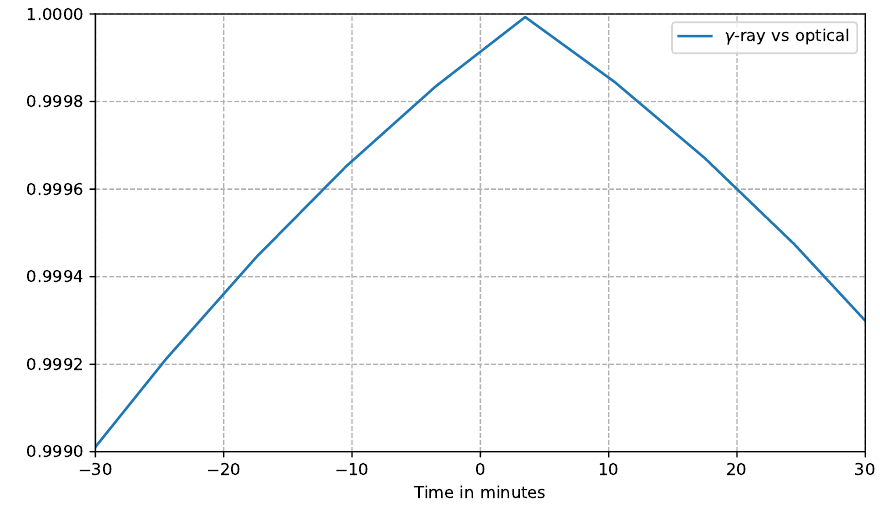
Figure 7. Strong correlation of γ vs optical of the variation of injection luminosity on minute time-scales. The correlation functions for the injection luminosity variation light curves show almost perfect correlations, with some time lags between optical, X-rays, and γ -rays. The time lags are indicative of different cooling time-scales; that is, longer cooling time-scales for the low-energy electron population producing X-rays (lags behind γ -rays and optical) while shorter for the high-energy population producing optical and γ